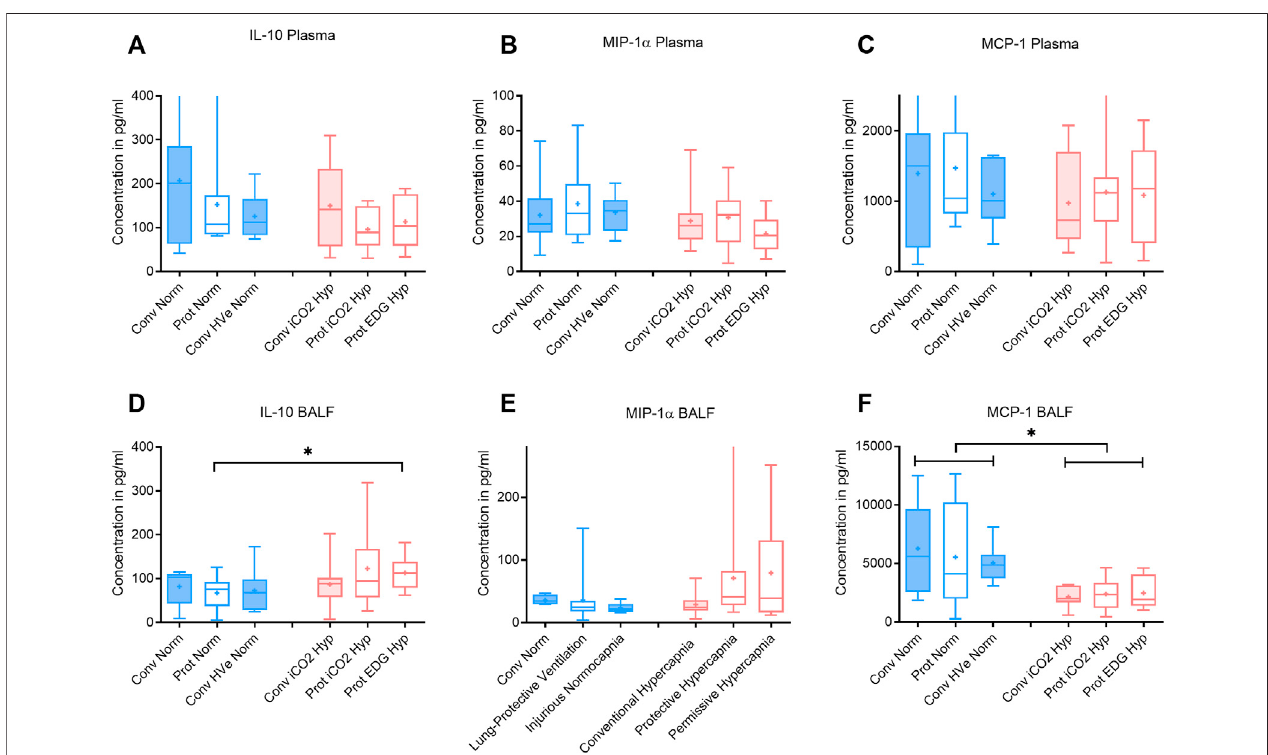
FIGURE 4 | Plasma and broncho-alveolar lavage fl uid (BALF) cytokines after 4 h of ventilation. Boxplot of IQR, mean, median, min-max (whiskers). Closed boxes: high tidal volumes; open boxes: low tidal volumes; blue color: normocapnia; red color: hypercapnia. * denotes signi fi cant differences between groups.